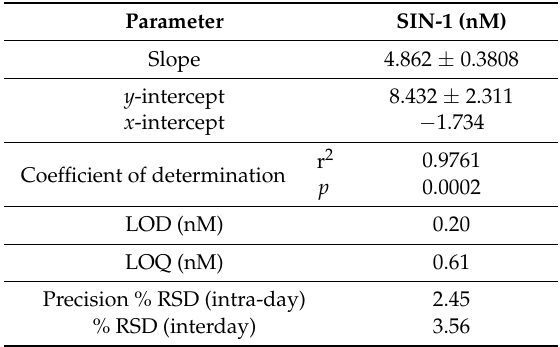
Table 1. Statistical parameters and linearity results based on the standard curves of the fluorescence intensity of the reaction between DAF-FM and the NO liberated from SIN-1 (over the range 1–10 nM). LOD: limit of detection; LOQ: limit of quantification.